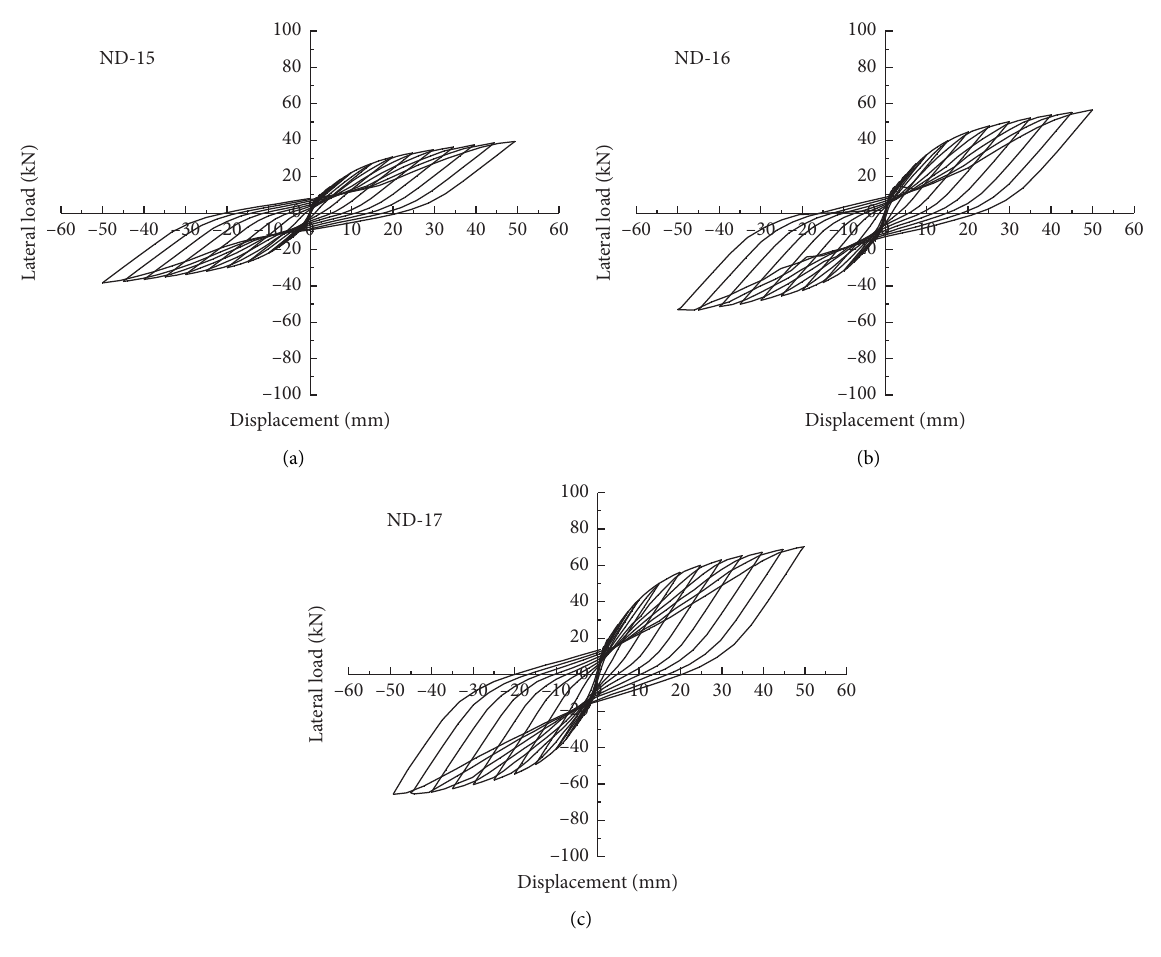
Figure 16: Hysteretic curves of slit width 100mm. (a) 0.4mm. (b) 0.6mm. (c) 0.8mm.